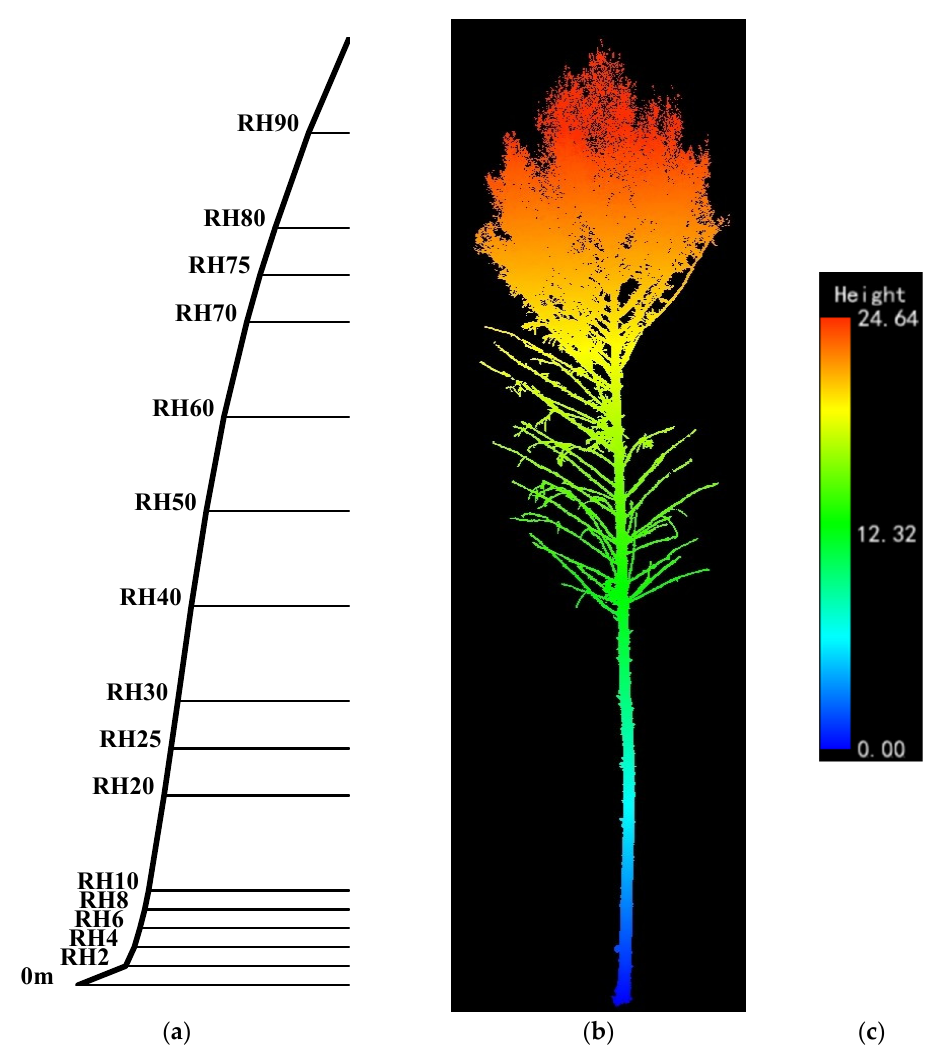
Figure 1. Diameter extraction position of a tree. ( a ) The height of the diameter extraction position; RH represents relative height. Example: RH40 represents the relative height in the 40th percentile or percentile height; ( b ) a larch colored by height; ( c ) the height (m) represented by different colors in ( b ).